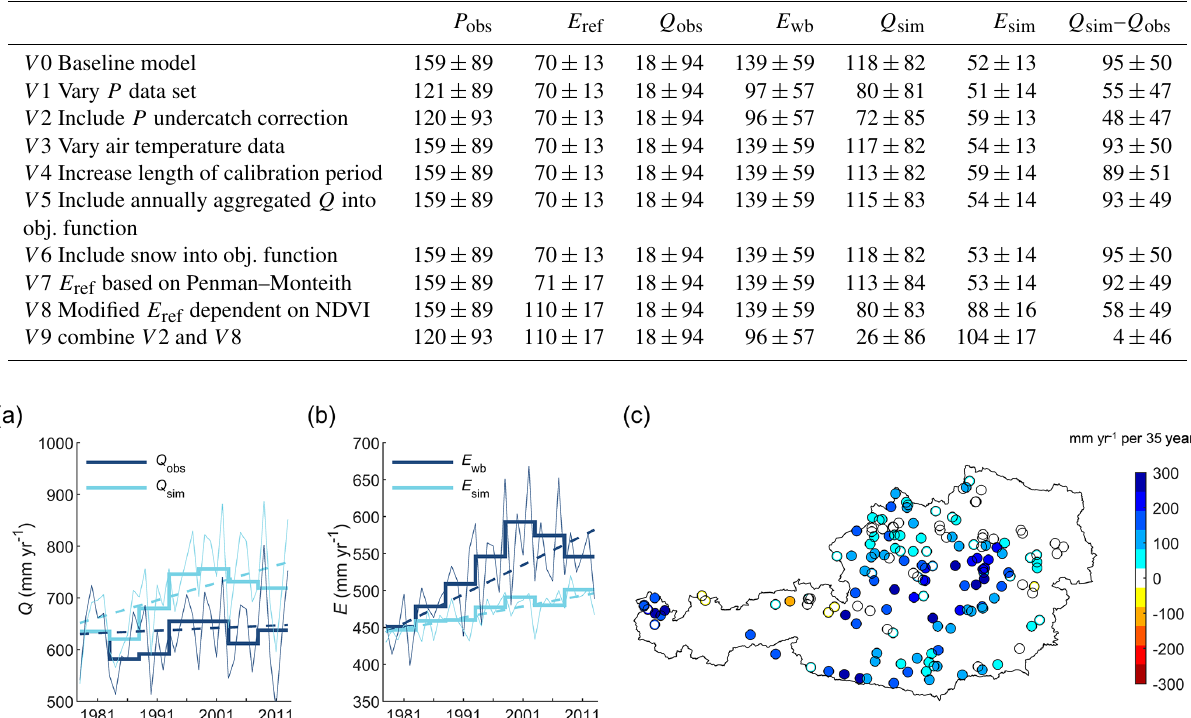
Figure 2. (a) Temporal variations in simulated discharge ( Q sim ) and observed discharge ( Q obs ) as averages over all 156 study catchments. (b) Temporal variations in simulated evaporation ( E sim ) and evaporation derived from the water balance ( E wb ) as averages over all study catchments. Note that E wb includes storage changes that are particularly relevant for the interannual variations. The thick lines show subpe- riod annual means, the thin lines show annual sums and the broken lines show linear trends. (c) Spatial pattern of the differences of simulated and observed trends in discharge. Filled circles indicate significant trends at p ≤ 0 . 05.